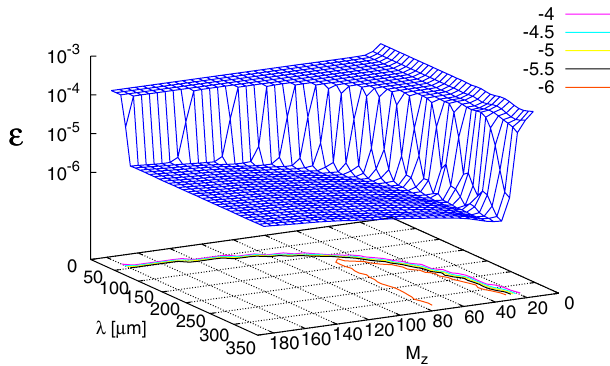
FIG. 8. Accuracy of FFT-based cosine expansion (red line), simple grid deposition (green line), grid-based truncated FCT FIG. 9. Accuracy (measured by the IMSE) for the cosine (blue), and a wavelet-denoised grid deposition (purple) for the approximation of the modulated flattop distribution as a function flattop distribution modulated with a sinusoidal perturbation with ¼ 1024 , (cid:8) ¼ 100 (cid:9) m and A ¼ 0 : 05 on a grid with resolution N of the longitudinal modulation wavelength (cid:8) and number of z ¼ 128 , and N ¼ 10 8 particles. Vertical lines denote minimal N cosine basis functions in the longitudinal direction ( M x ¼ 1024 , N ¼ 128 . The number of transverse basis N ¼ 10 8 , N wavelengths representable with grid and cosine approximations z x ¼ 40 . The contour curve denoting the functions is fixed at M (from left to right), as predicted by Eqs. (39) and (35). The x ¼ 100 and M ¼ 40 coefficients. The dropoff in accuracy of about 2 orders of magnitude corresponds cosine expansion has M z x (cid:5) 7200 (cid:9) m , as predicted by Eq. (35). wavelet family used is Daubechies of order 10. to (cid:8)M z